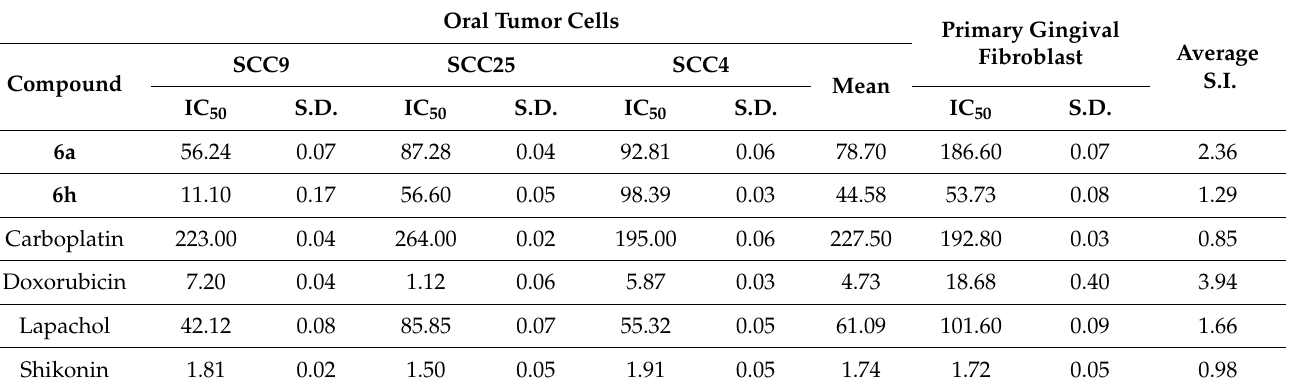
Table 2. Characterization of the most selective compounds in other OSCC cells. The IC 50 ( µ M) of three different OSCC cell lines (SCC 4, SCC-9 and SCC-25) and normal fibroblast cells followed by the average of the selectivity index of compounds 6a and 6h were calculated in the same way as in Table 1. All experiments are results of at least 3 independent experiments. Oral Tumor Cells Primary Gingival